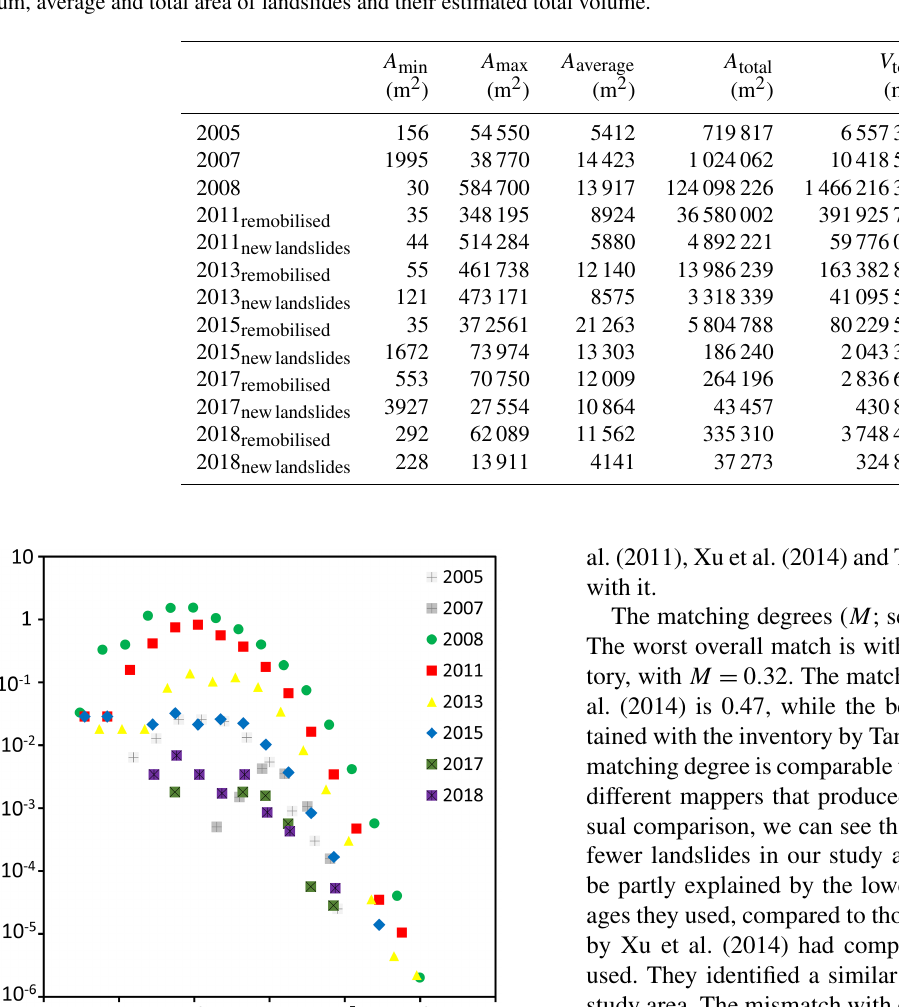
Table 3. Simple statistics of the landslides included in the multi-temporal inventory. Note that the volumes in this table were calculated according to the area–volume scaling proposed by Xu et al. (2016). A min , A max , A average , A total and V total are, respectively, the minimum, maximum, average and total area of landslides and their estimated total volume.